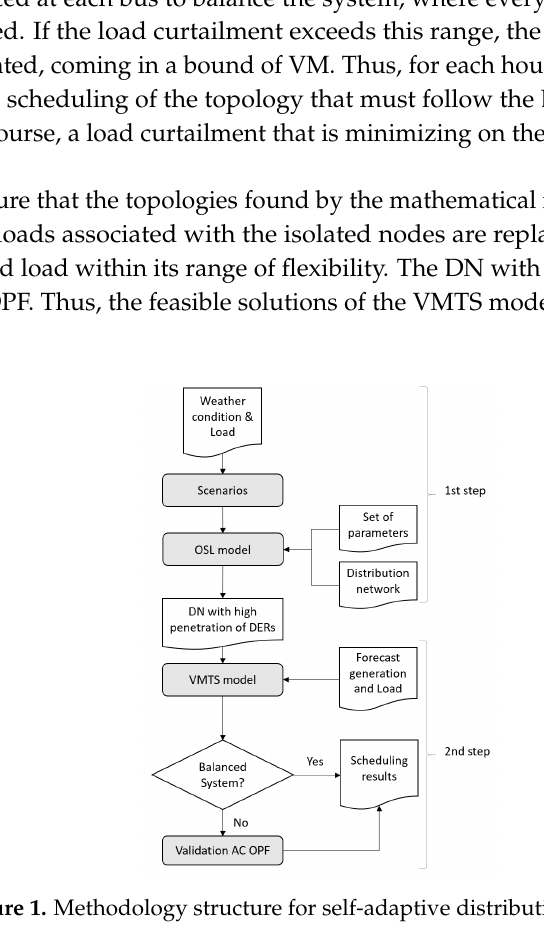
Figure 1. Methodology structure for self-adaptive distribution